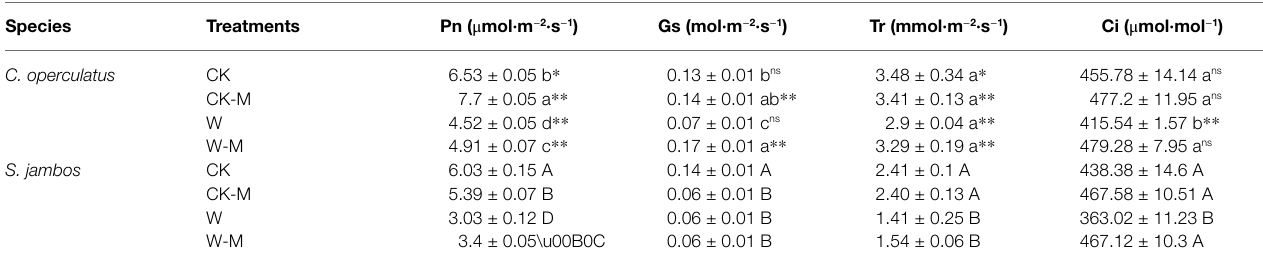
TABLE 3 | The variations of Pn, Gs, Tr, and Ci in C. operculatus and S. jambos among different treatments.